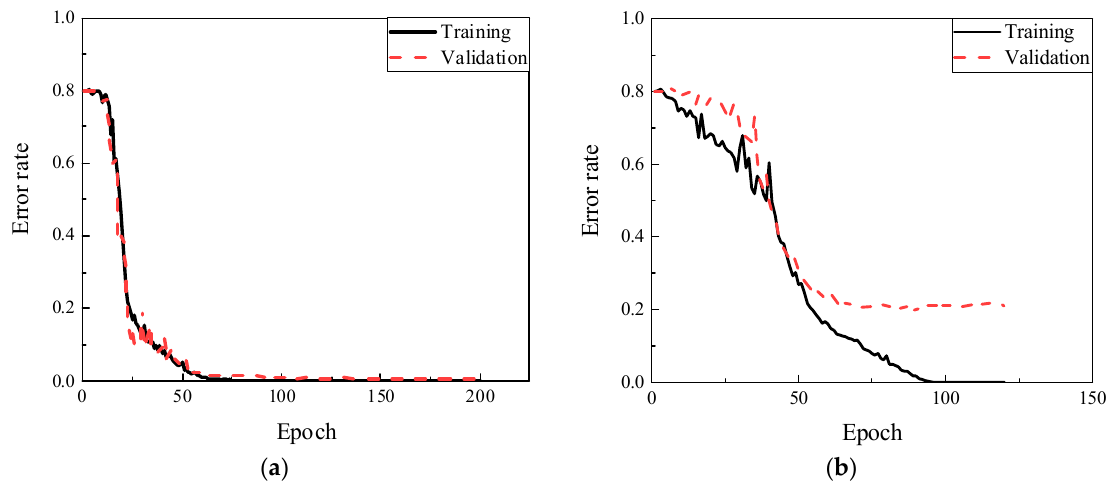
Figure 23. Training and validation results. ( a ) SNR = 70 dB. ( b ) SNR = 60 dB